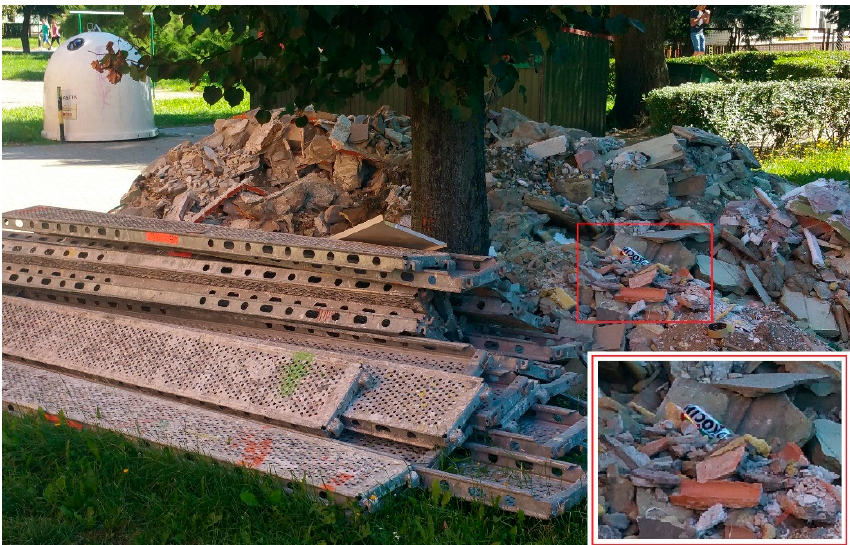
Figure 14. Beer can in the assembly yard at the examined construction site (authors’ archive).